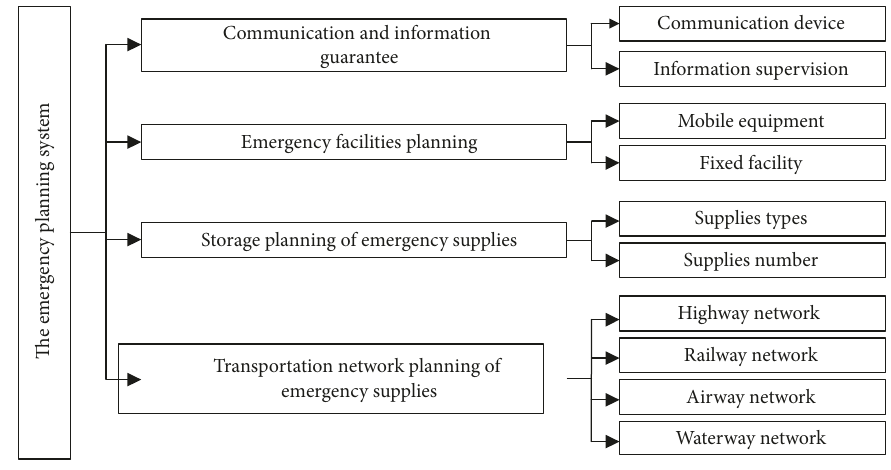
Figure 1: The main content of emergency planning